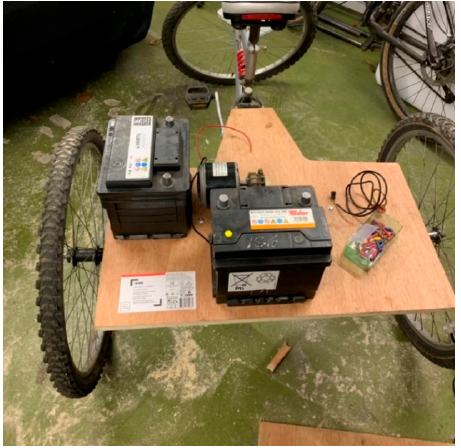
Figure 13. Platform housing electrical components.